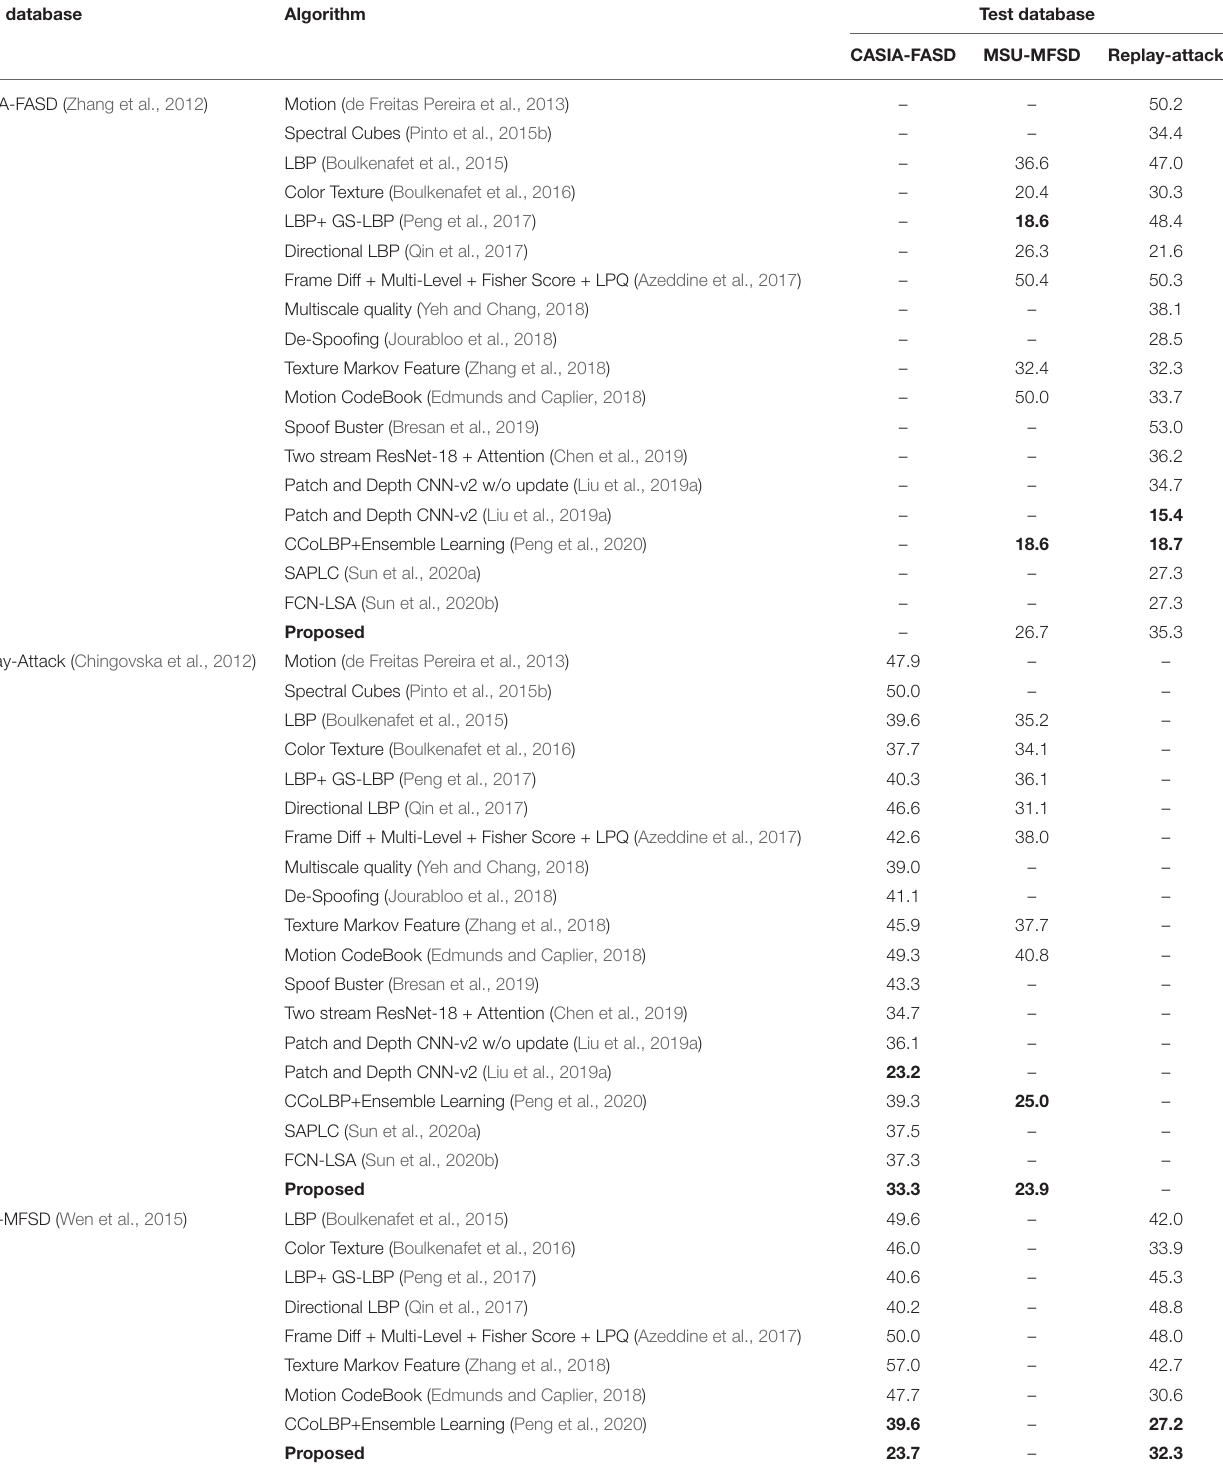
TABLE 10 | Comparison with existing results on the video based presentation attack detection under cross dataset setting. Train database